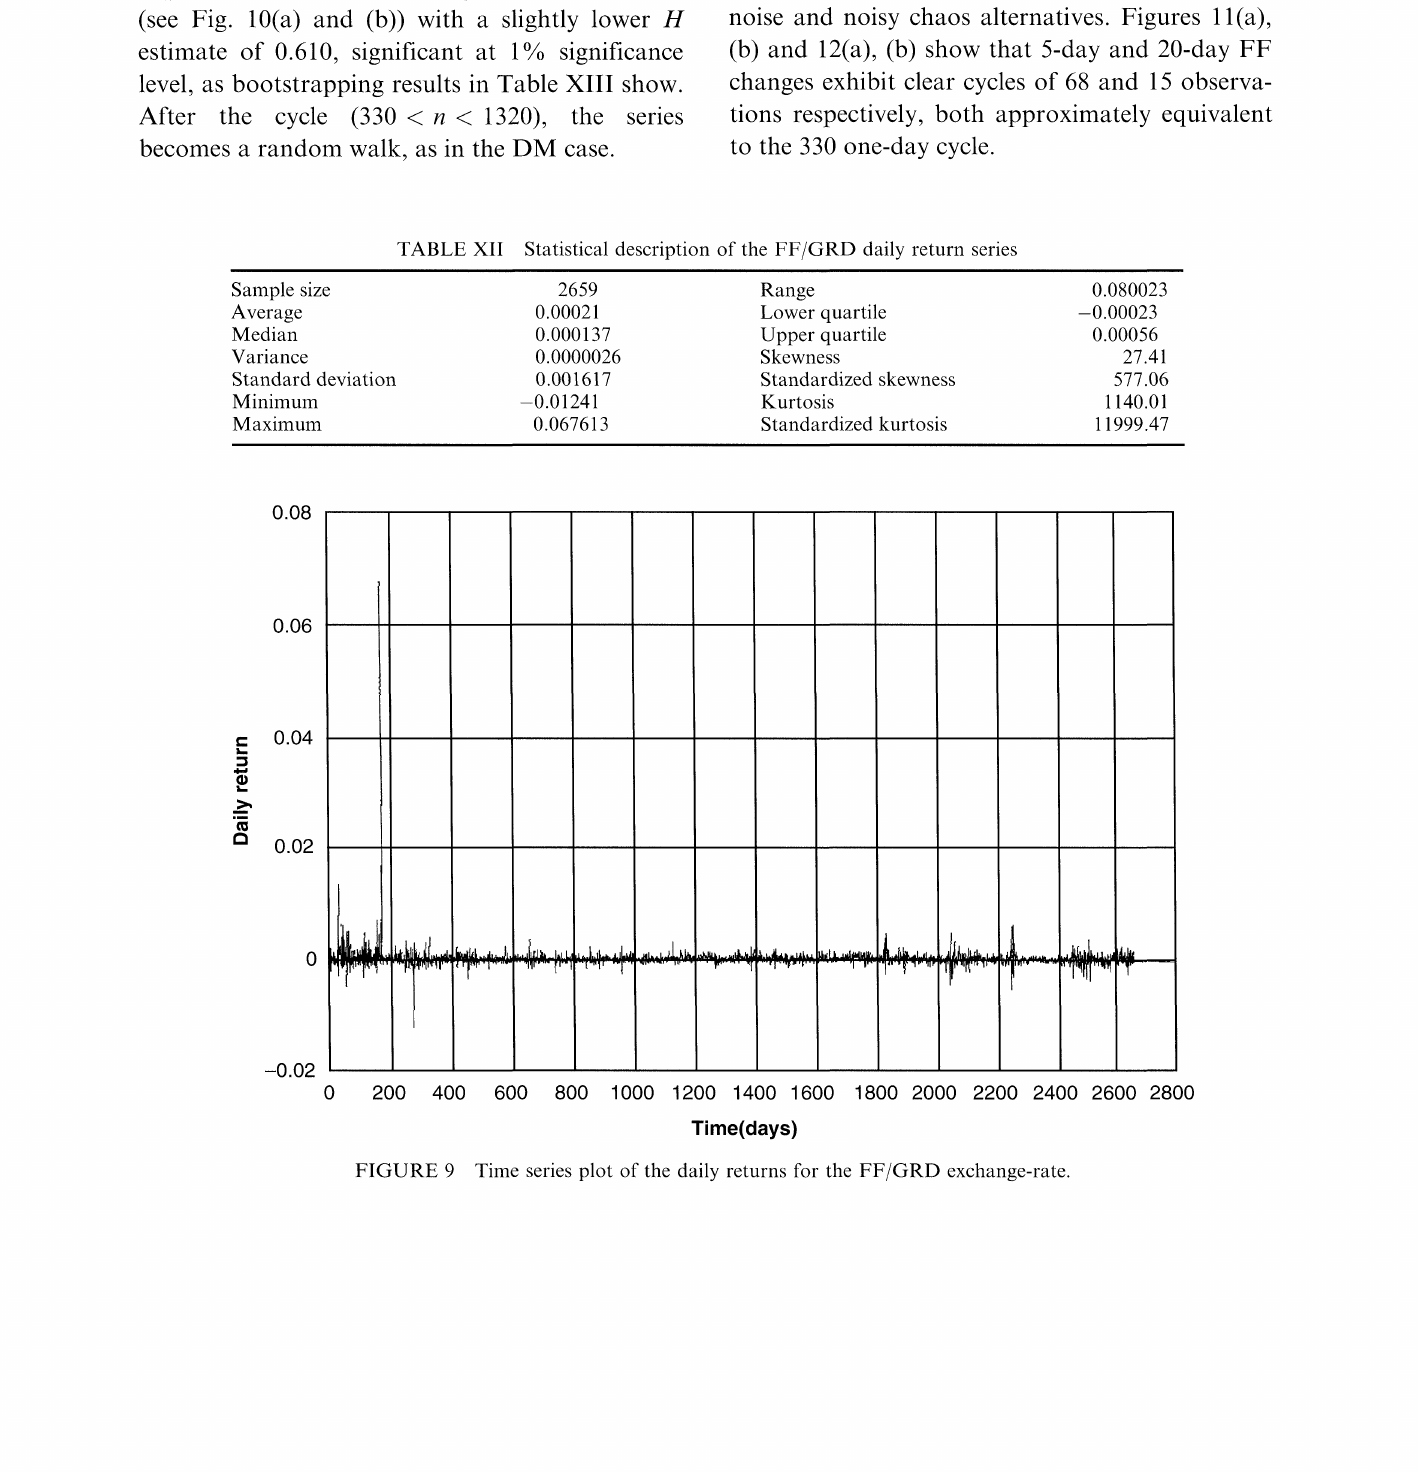
FIGURE 9 Time series plot of the daily returns for the FF/GRD